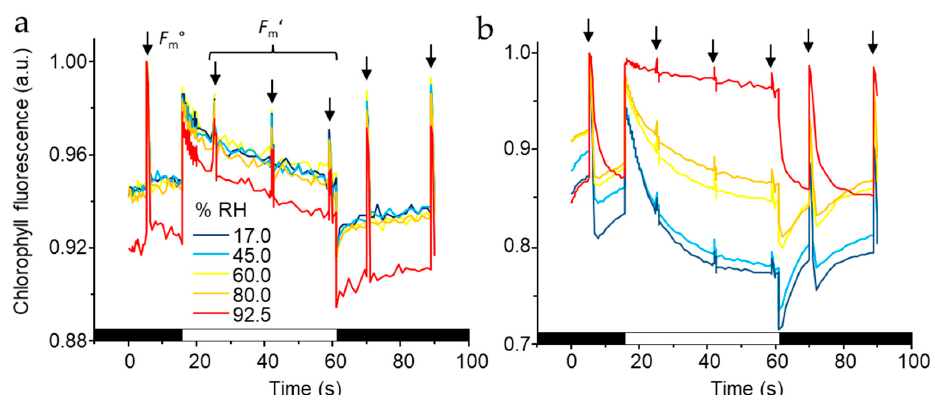
Figure 6. Chlorophyll fluorescence kinetics revealing effects of contrasting RH on photosynthesis. Traces are of ( a ) dry cells equilibrated to various RH, as indicated in the legend, for two weeks under light and ambient oxygen, and ( b ) after four hours re-hydration. Arrows in ( a ) indicate saturating pulses of light, given at the same time in ( b ), during the dark ( F m °, first measurement) or during illumination at 200 µmol photon m − 2 s − 1 ( F m ’). Black and white bars on the X-axis indicate dark and illumination, respectively. Data are normalized to F m ° and are averages of three filters.